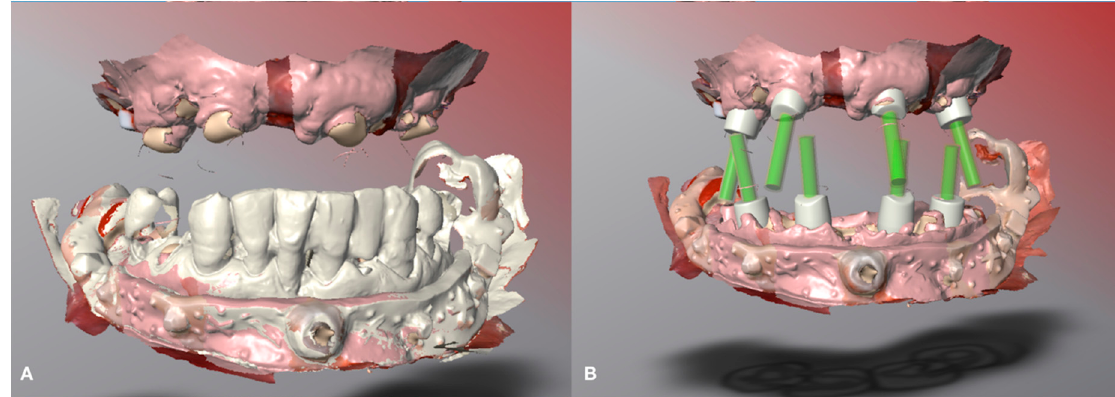
Figure 7. Scan abutments and the lower digital index placement. ( A ) Scan abutment placement after implants insertion. ( B ) Placement of the digital index immediately after surgery to record the postoperative digital impression. ( C ) Postoper- ative digital impression in frontal view. ( D ) Occlusal view of the mandibular postoperative digital impression superim- posed with the preoperative scan using the resin digital index as reference.